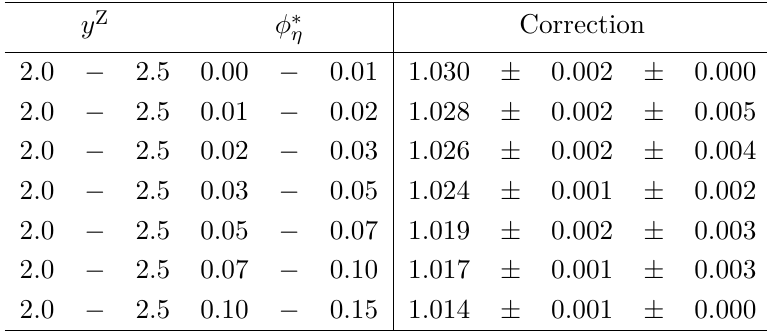
Table 5. Final state radiation correction used in the y Z − p Z The first uncertainty is statistical and the second is